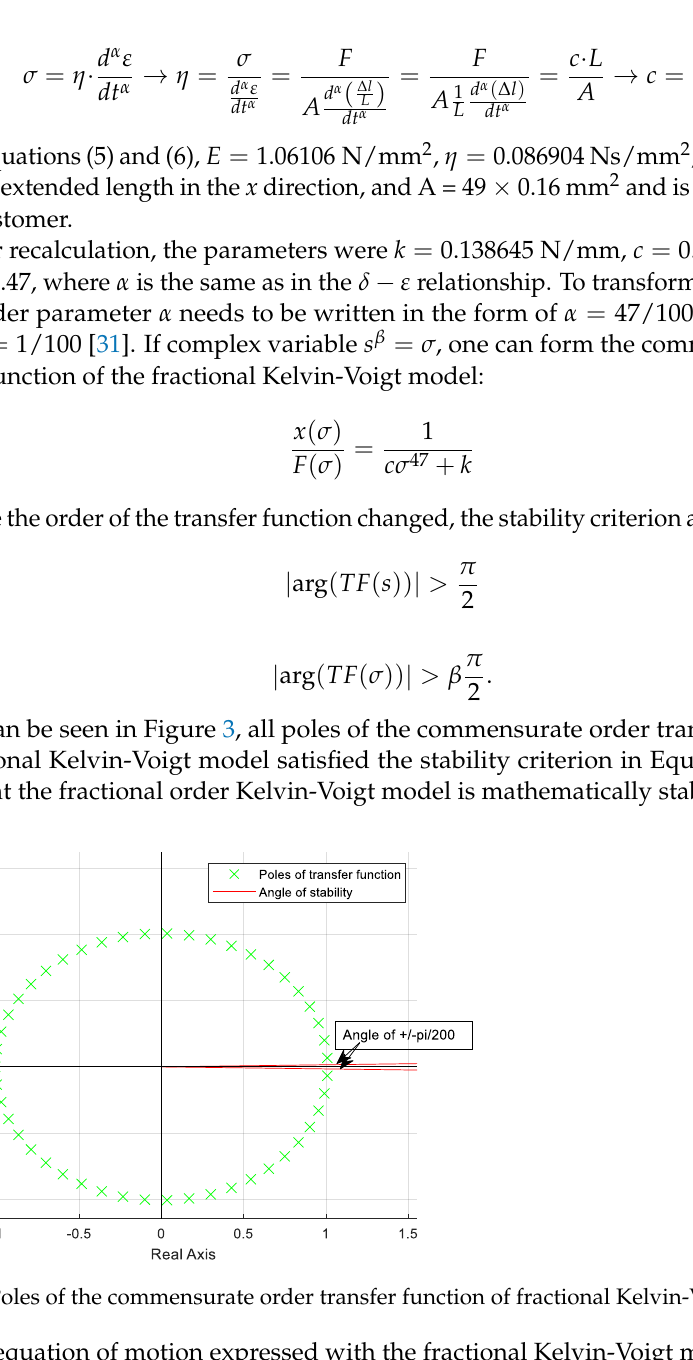
where m = 0.0001 kg and represents the mass of the